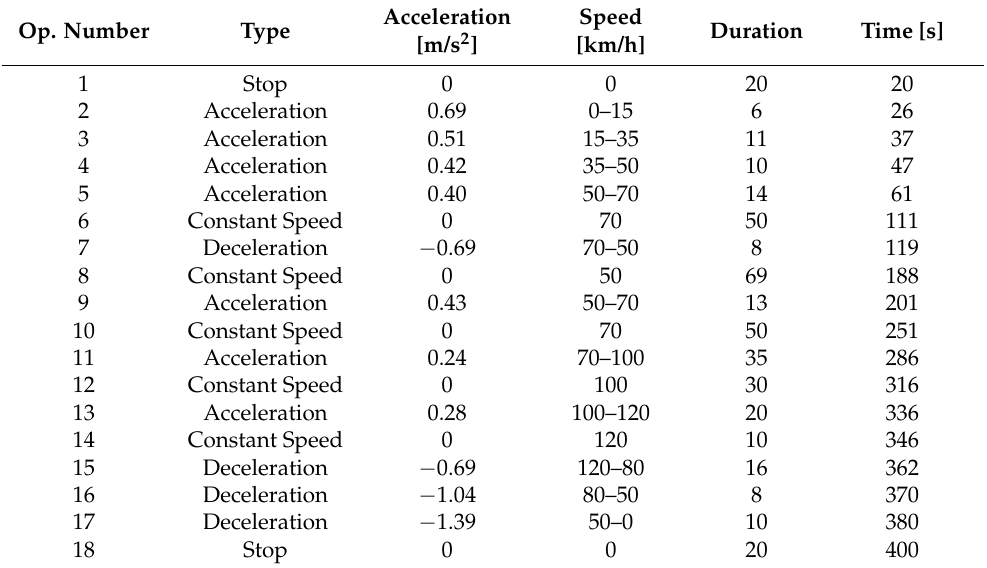
Table 2. Operations of the elementary extra-urban cycle [30]. Op.